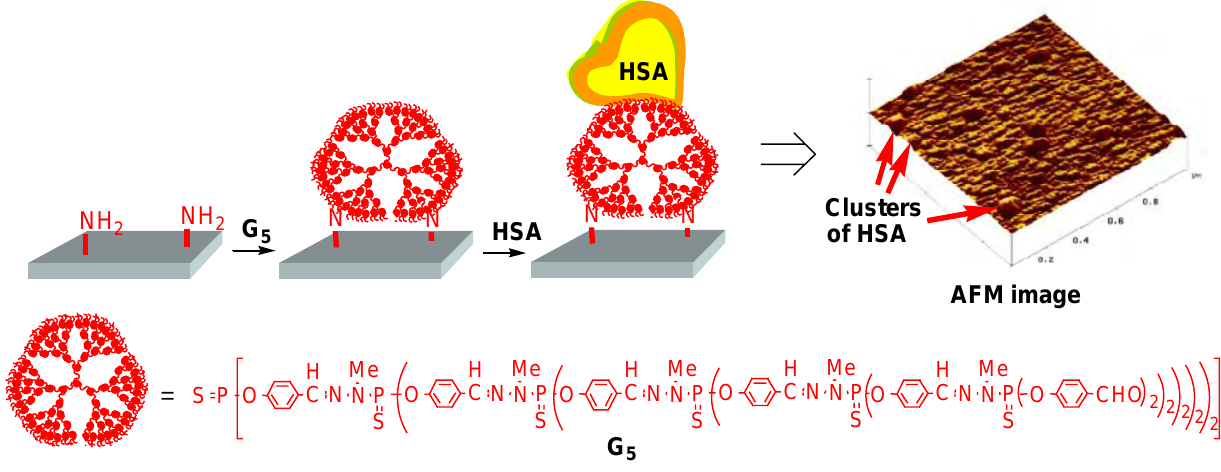
Figure 7. Structure of the fifth generation phosphorus dendrimer built from a trifunctional core and bearing 96 aldehyde end groups, its reaction with a slide functionalized by NH subsequent immobilization of Human Serum Albumin, analyzed by